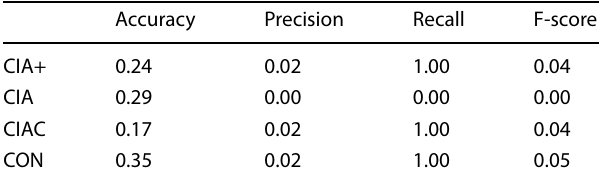
Table 10 Results: information leakage data